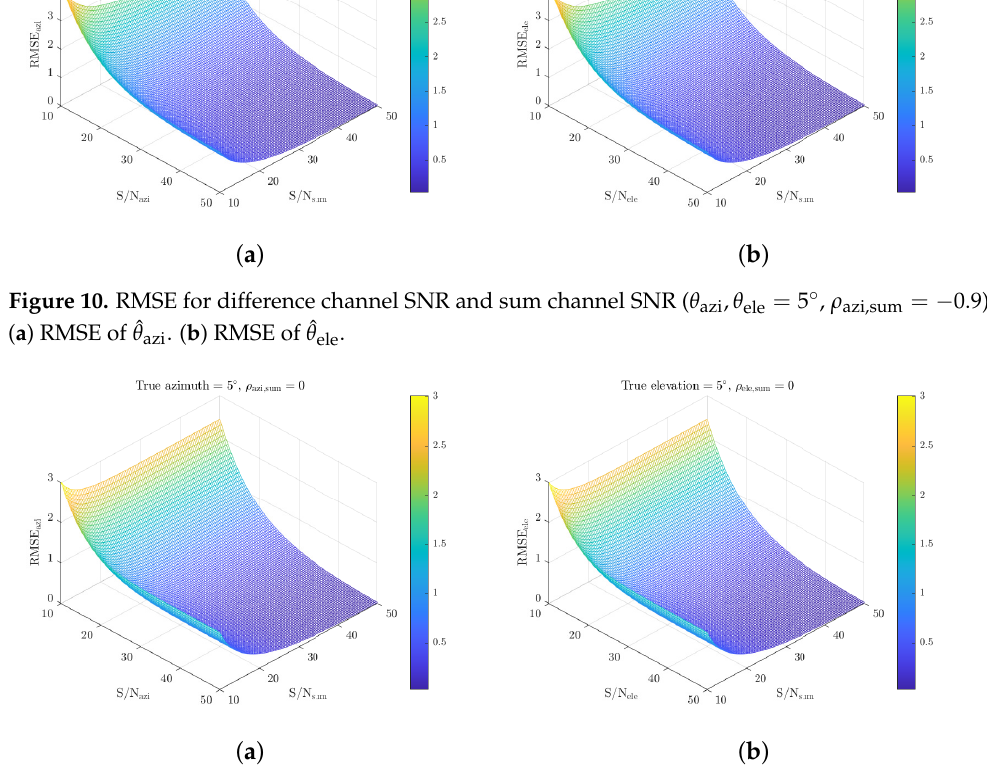
Figure 11. RMSE for difference channel SNR and sum channel SNR ( θ azi , θ ele = 5 ◦ , ρ azi,sum =